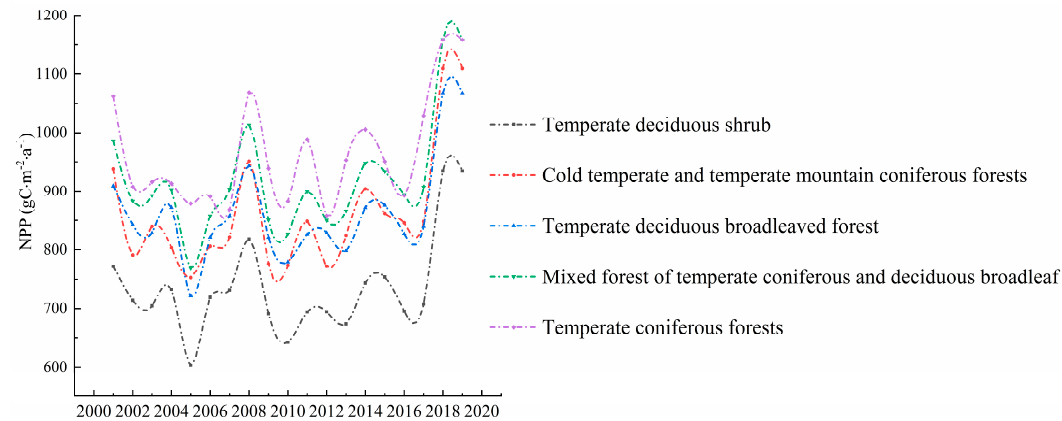
Figure 7. The inter-annual variation of different forest types in Northeast China, during the period of 2001–2019.